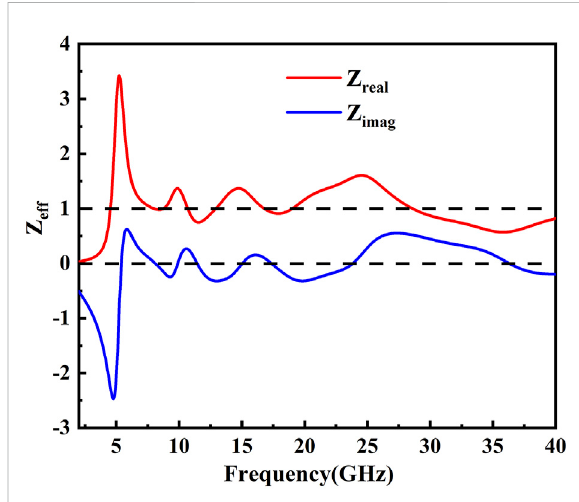
FIGURE 9 The effective input impedance of the double-cross shape metamaterial